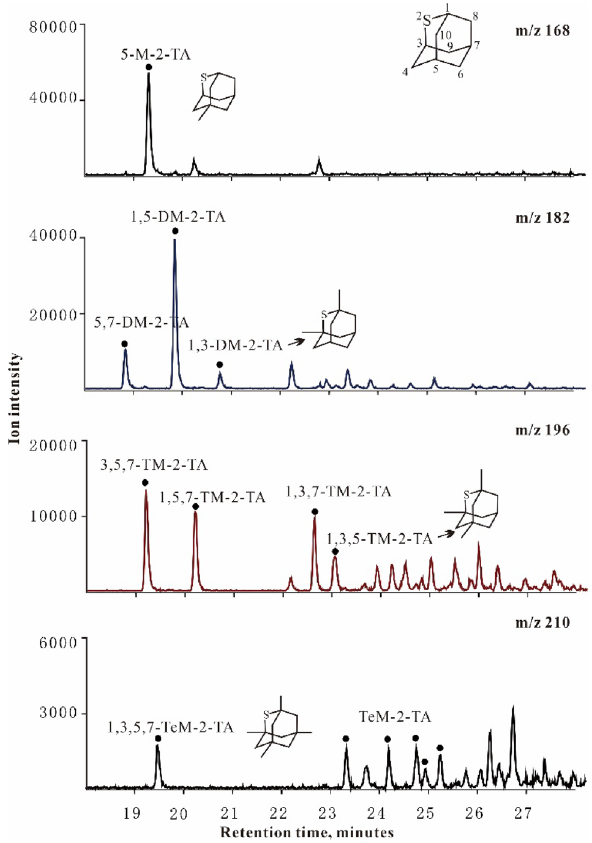
Figure 1. Mass chromatograms of alkylated thiadiamantanes in the sulfidic fraction of the products from TSR experiments (Group1) at 480 °C. 5-M-2-TA = 5-methyl-2-thiaadmantane; 5,7-DM-2-TA = 5,7-dimethyl-2- thiaadmantane; 1,5-DM-2-TA = 1,5-dimethyl-2-thiaadmantane; 1,3-DM-2-TA = 1,3-dimethyl-2-thiaadmantane; 3,5,7-TM-2-TA = 3,5,7-trimethyl-2-thiaadmantane; 1,5,7-TM-2-TA = 1,5,7-trimethyl-2-thiaadmantane;